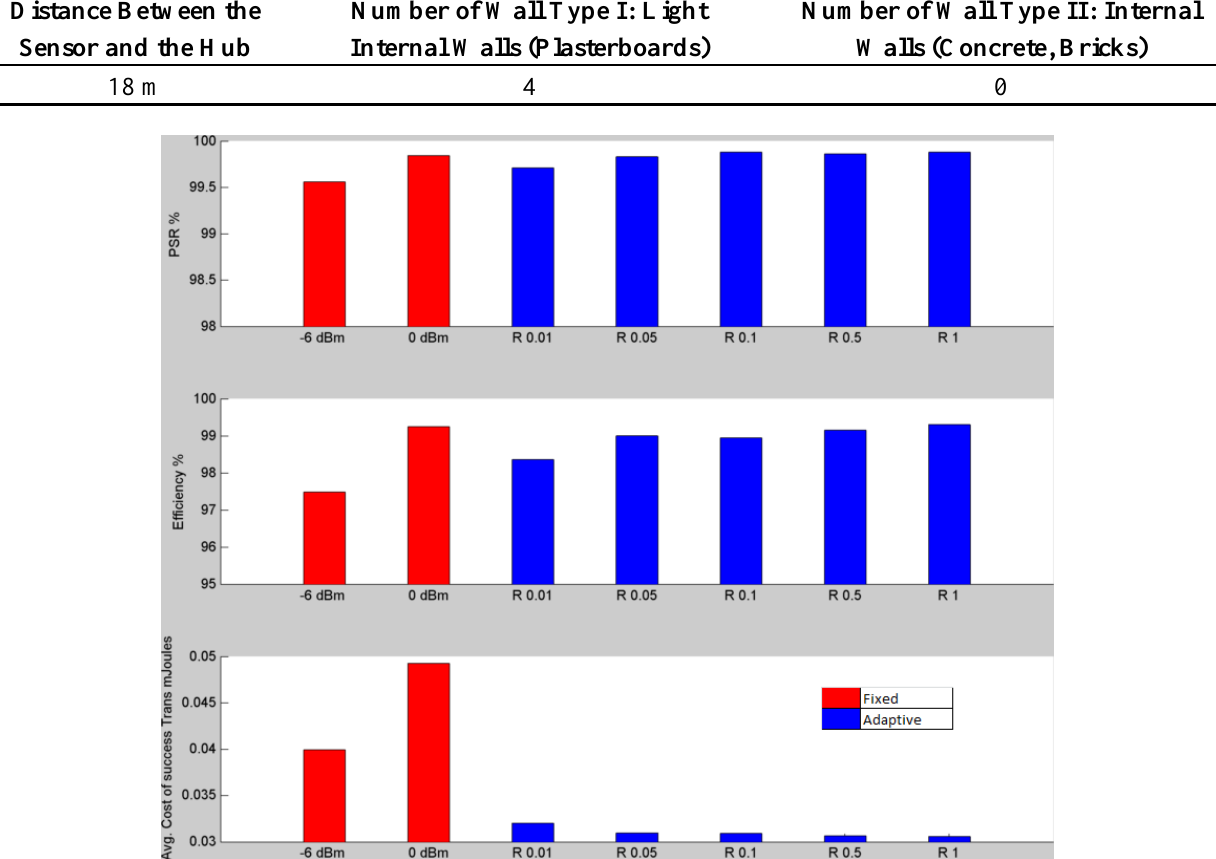
Figure 4. Comparison of the PSR, efficiency and average cost of successful transmission when the distance between the sensor and the hub is 18 m. The minimal cost of fixed power transmission is achieved at –6 dBm. The minimum energy consumption is at −6 dBm, primarily because of similar PSR and efficiency as at 0 dBm. In terms of energy efficiency, the adaptive protocol consumes 30% less energy than the fixed power transmission at −6 dBm when R is 1. The efficiency of the adaptive protocol at R = 1 is higher than fixed power transmission at –6